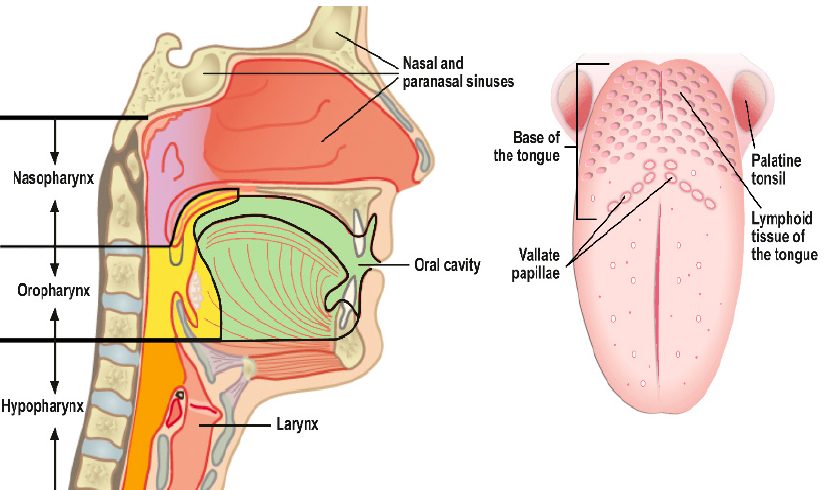
Figure 1. A schematic presentation of the upper aero-digestive tract. This review also includes the more distally located trachea and esophagus. The figure is modified from the original figure pub- lished as Figure 3.1, page 16, Report 2/2019, Should boys’ HPV vaccinations be included in the